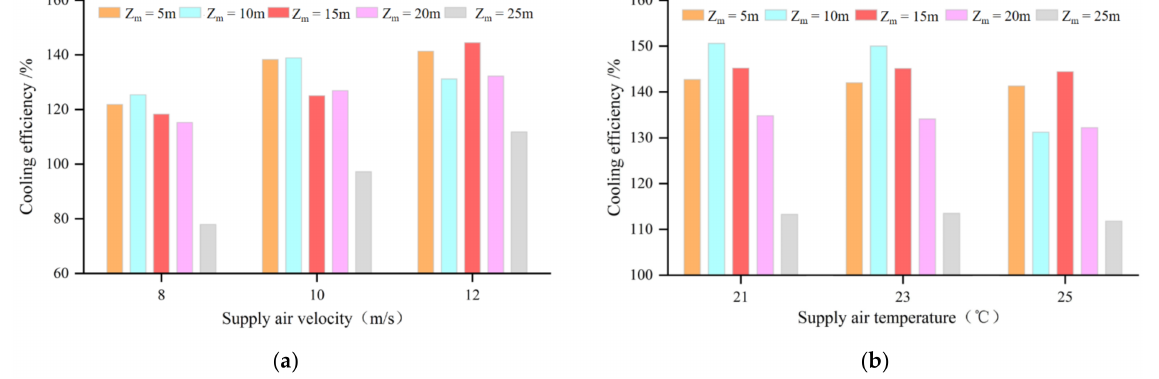
Figure 11. Comparisons of the CE at different air supply conditions with respect to different Z m ( a ) different supply air velocities; ( b ) different supply air